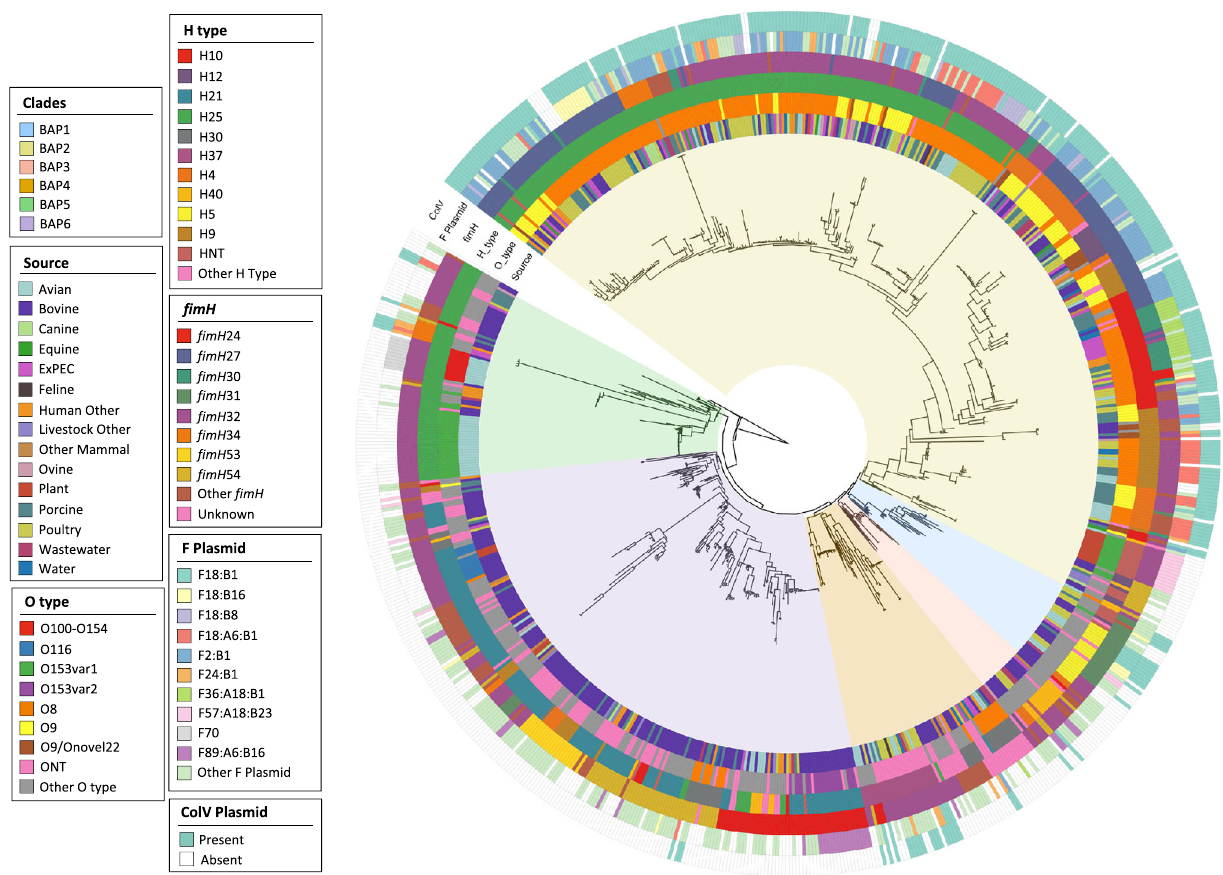
Fig. 2 Phylogenetic tree with metadata. Maximum-likelihood core gene phylogeny of 752 E. coli ST58 rooted on ST155 strain MOD-EC5019 with genotypic information and